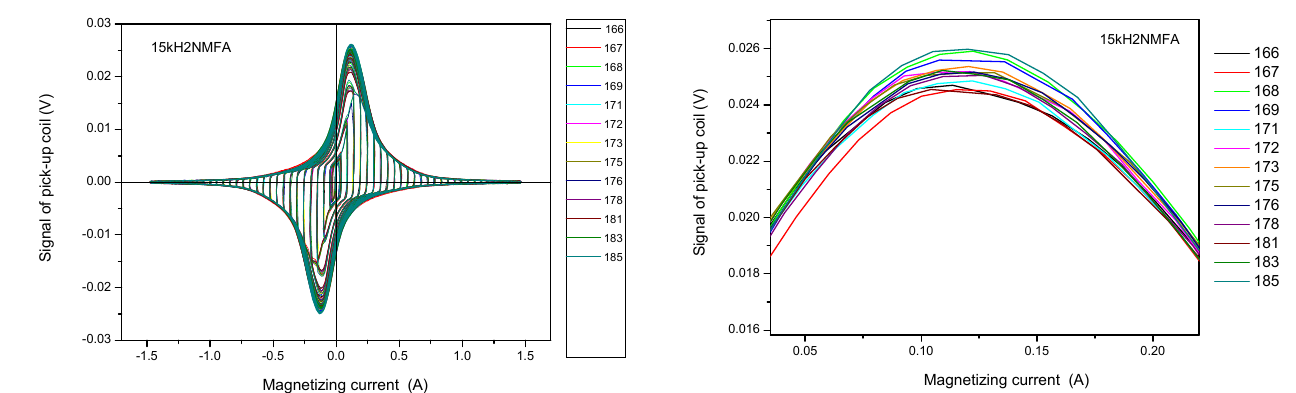
Figure 9. Measured permeability loops of 15kH2NMFA samples before irradiation. The right panel shows the magnified part of the left graph [11].